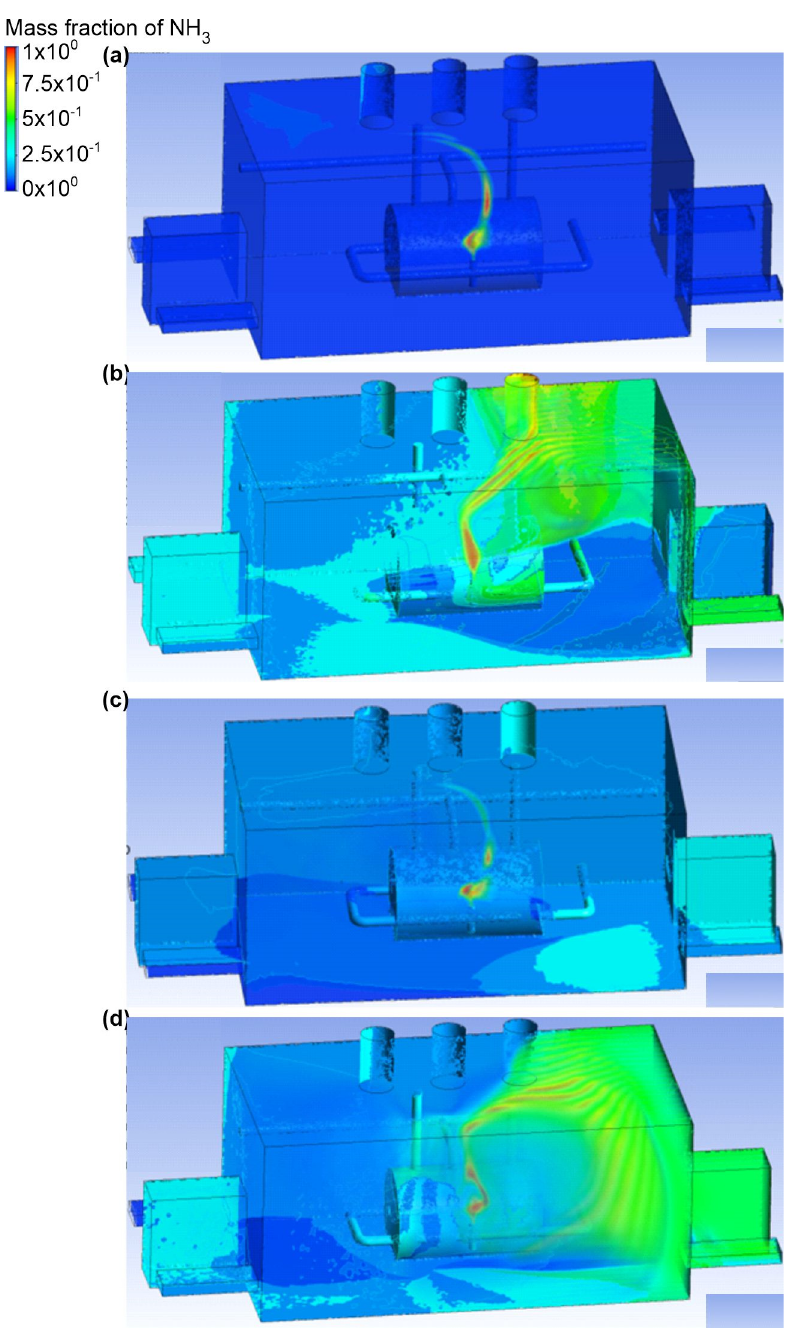
Figure 2. Ammonia distribution in the engine room for: ( a ) scenario A, ( b ) scenario B, ( c ) scenario C, and ( d ) scenario D.